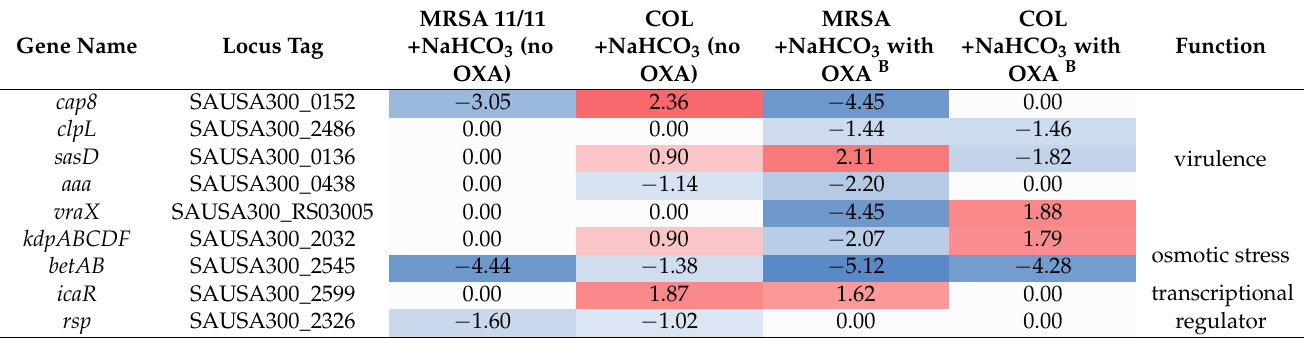
Table 3. Genes of interest altered in both NaHCO 3 -responsive and non-responsive strains (log 2 fold change A